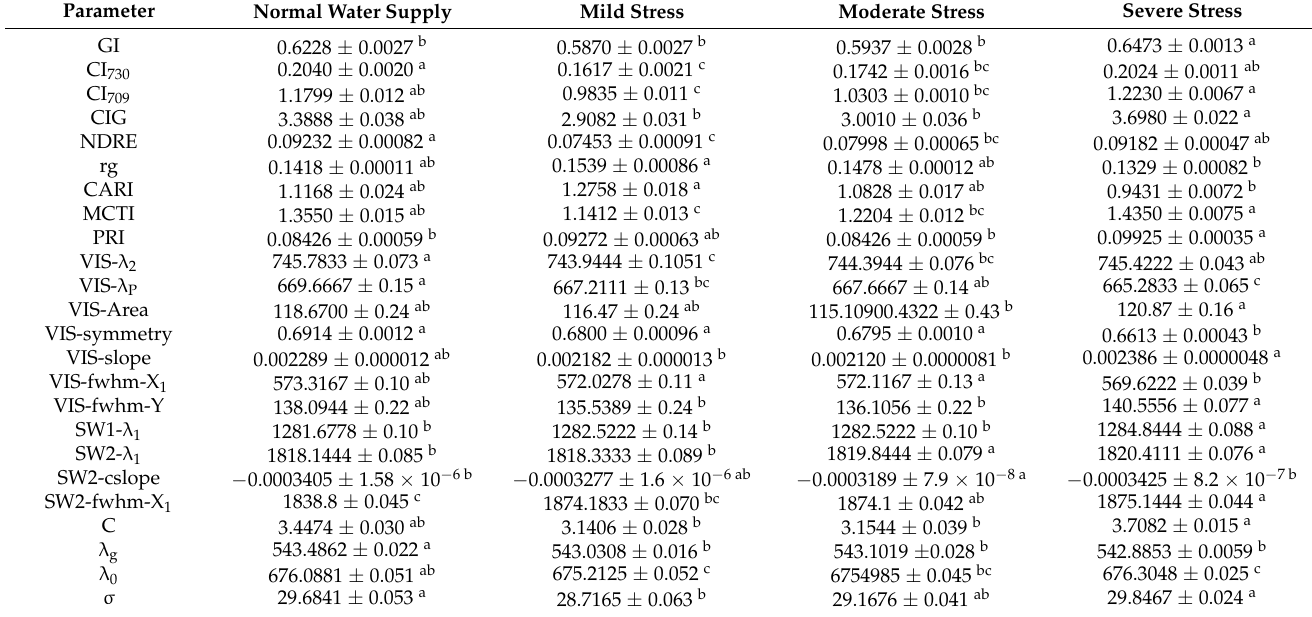
Table 2. Performance of the spectral parameters of the normal water supply, mild stress, moderate stress, and severe stress in the initial stage of rewatering (i.e., day 28). The data are presented in the form of the mean ± standard error, and significant differences are indicated by different letters in the same